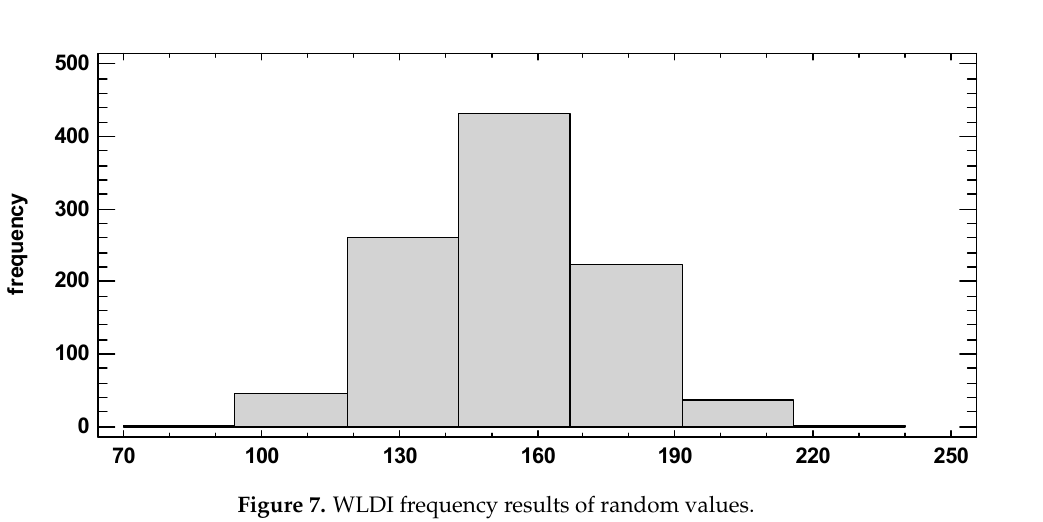
Figure 7. WLDI frequency results of random values. Table 5. Descriptive statistics of the results of complex